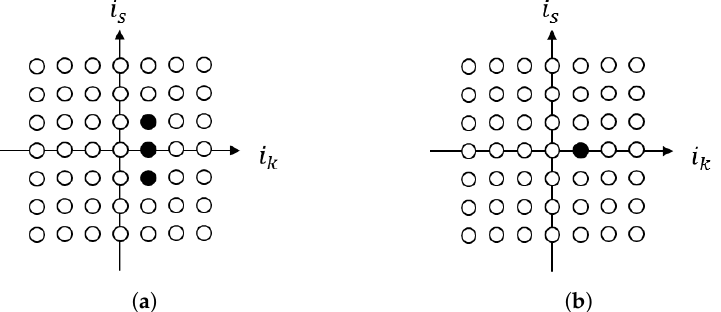
Figure 8. Illustration of required input and output lags (filled circles) for calculation of y ( k , s ) based on Equation (8) on two-dimensional lattice. ( a ) Index set M y ; ( b ) index set M u